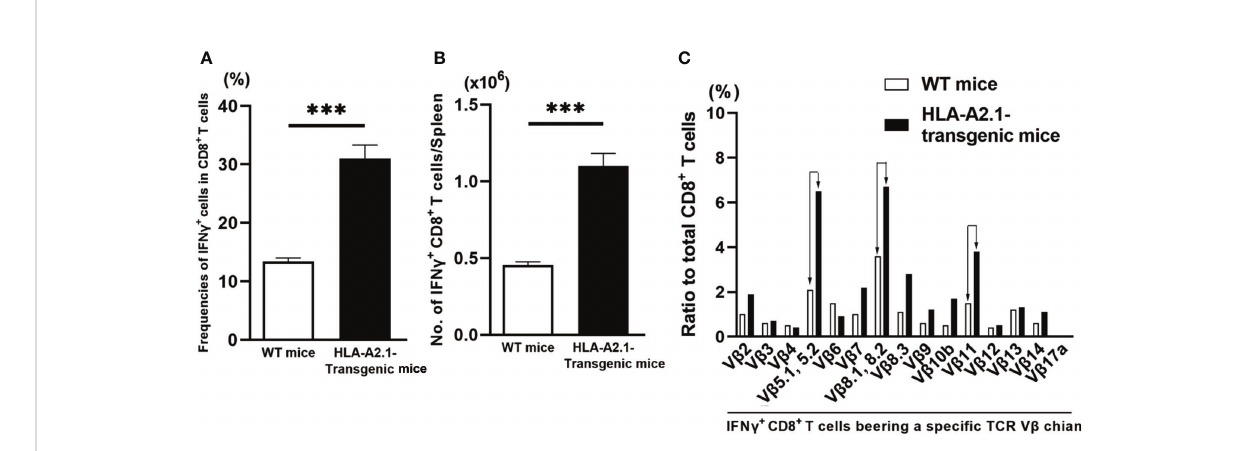
FIGURE 4 T. gondii -infected HLA-A2.1-transgenic mice have larger numbers of IFN- g -producing CD8 + T cells than do infected WT control mice in association with increased usages of TCR V b 5, V b 8.1, 8.2, and V b 11 in their IFN- g -producing CD8 + T cells. CD8 + T cells were puri fi ed from the spleens of HLA-A2.1-transgenic and WT control mice at 4-5 weeks after infection with T. gondii . (A) The frequencies and (B) numbers of IFN- g + cells in the CD8 + T cells were measured by fl ow cytometry. (C) The usages of TCR V b chains among the IFN- g + CD8 + T cells were also measured by fl ow cytometry. *** P